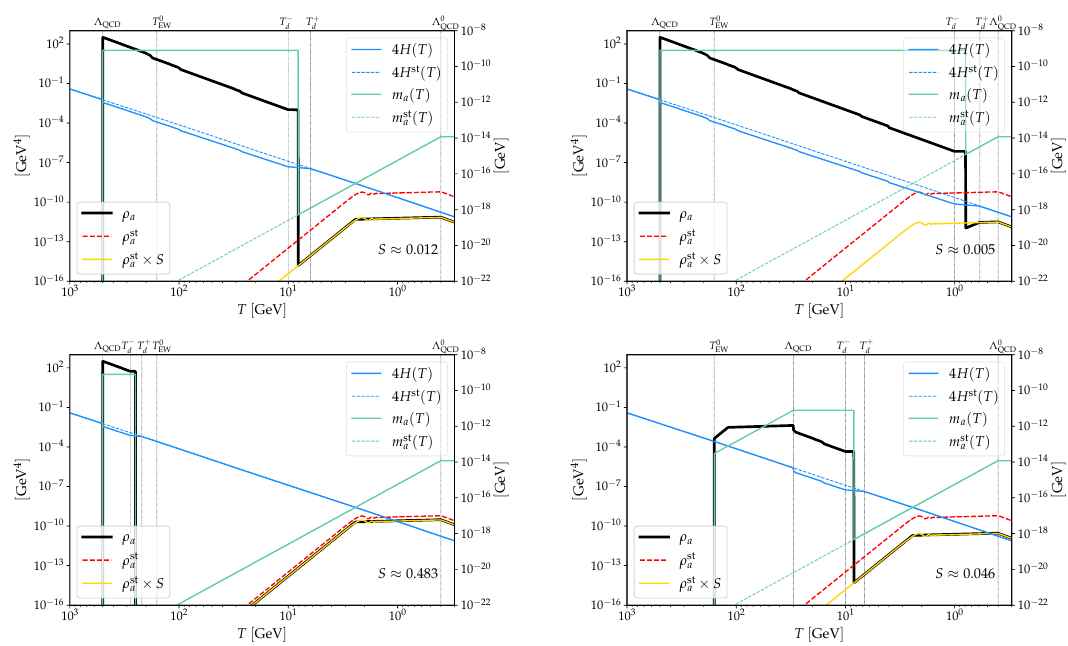
Figure 3 . Examples of the evolution of H , m a , and ρ a (as indicated) and final suppression factor S for four choices of parameters: upper left: [Λ [500 , 1] GeV ; lower left: [Λ of H , the values of T the time of the corresponding transitions in behavior.